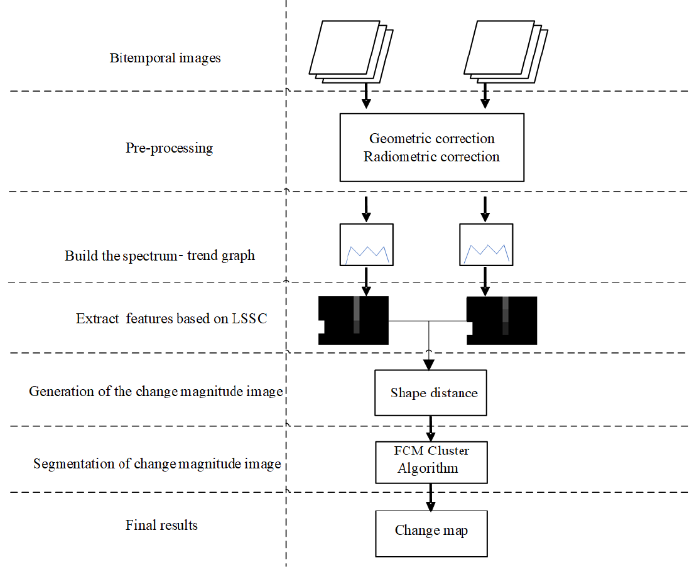
Figure 1. The flow chart of the proposed algorithm.